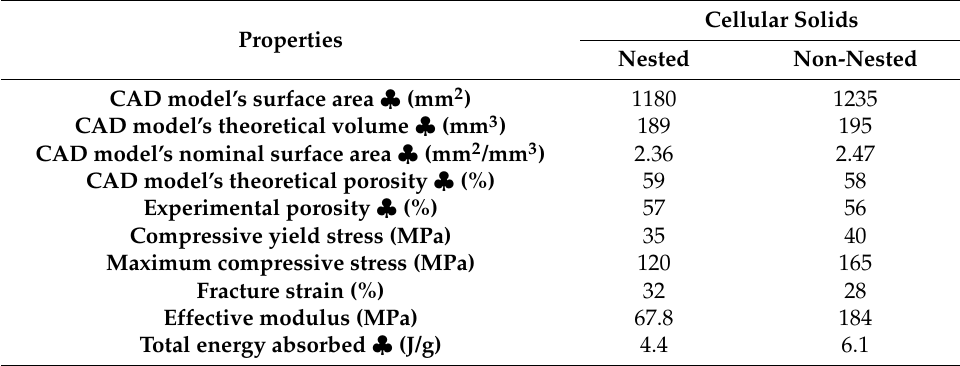
Table 2. Properties of the nested and non-nested cellular solids.